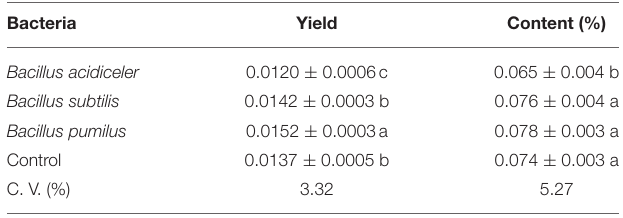
TABLE 5 | Effect of growth-promoting bacteria on yield and content of essential oil of roses cv. Black Prince.